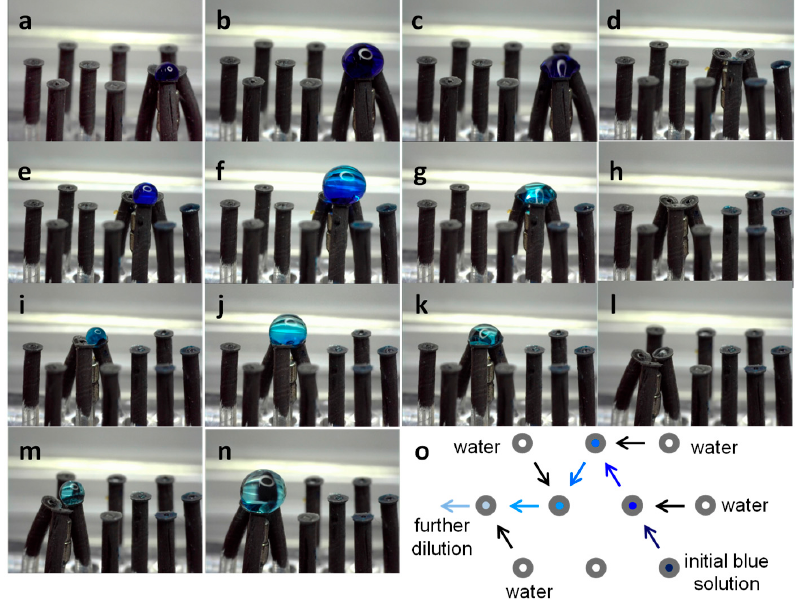
Figure 6. Dilution sequence. ( a ) Magnet #1 is raised to bring the three nozzles at the bottom-right edge of the template into contact, 2 µ L of the initial blue solution (50% ethanol in water) are released. ( b ) Initial dilution with water stream. ( c ) Product from dilution 1 sucked-in for transfer to next stage. ( d ) Magnet #1 down and magnet #2 up, next set of nozzles are brought into contact. ( e ) Droplet from dilution 1 released and ( f ) mixed with fresh water for second dilution step. ( g ) Dilution 2 product sucked-in. ( h ) Magnet #2 down and magnet #3 up, next set of nozzles in contact. ( i ) Droplet from dilution 2 released and ( j ) mixed with fresh water for the third dilution. ( k ) Product from third dilution sucked-in for transfer. ( l ) Magnet #3 down and magnet #4 up, next group of nozzles into contact. ( m ) Drop from dilution 3 released and ( n ) mixed with fresh water for the fourth dilution. ( o ) Sketch of the route followed for this dilution